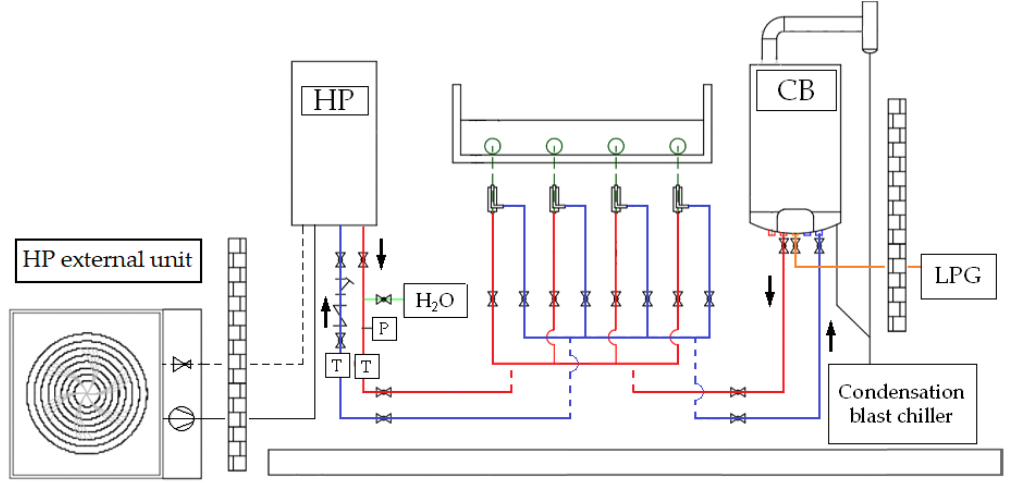
Figure 6. Detail of the scheme adopted at the basal side (heat pump (HP) and condensing boiler (CB) were connected to different benches).